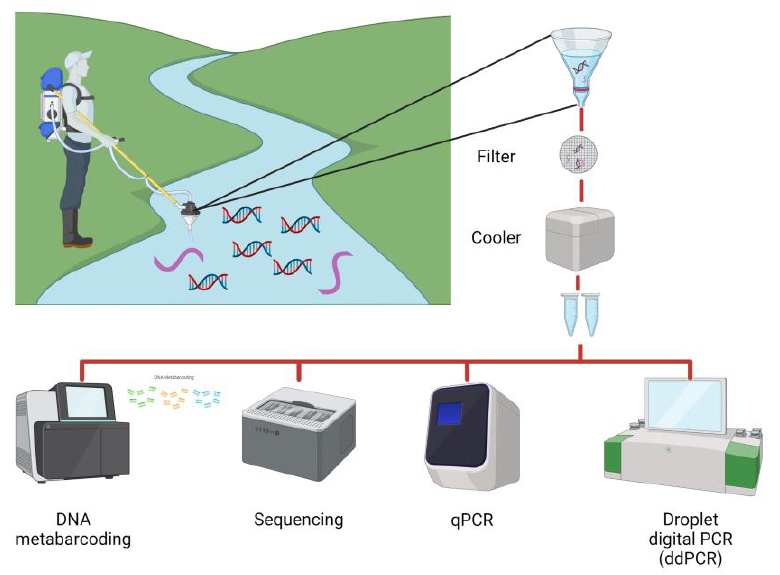
Figure 1. Different methods of eDNA/eRNA quantification. qPCR, ddPCR, metabarcoding, se- quencing, and RT-PCR are generally used to quantify the presence of different organisms from water samples.